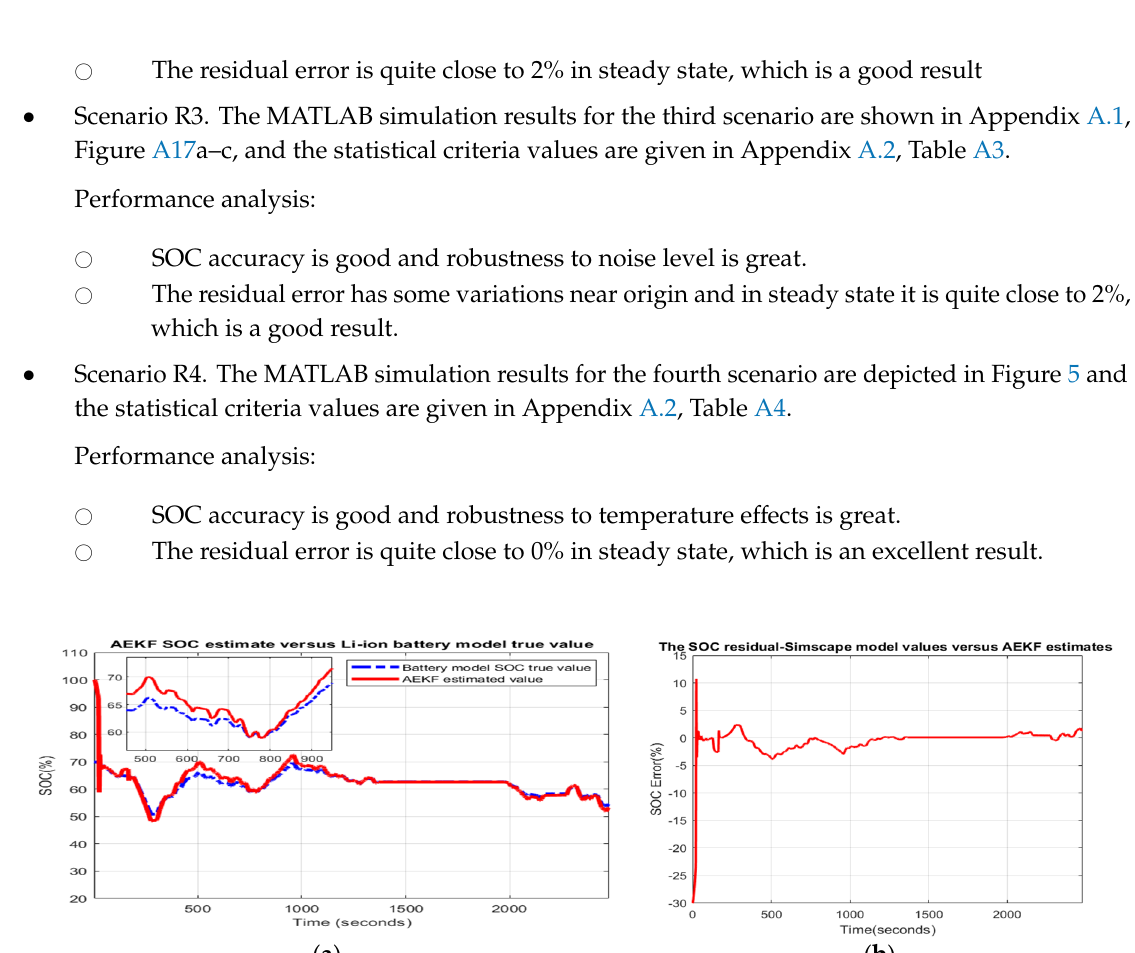
( b ) Figure 3. Robustness to simultaneous changes, SOCini = 0.2, and output temperature profile changes; ( a ) AEKF SOC value versus battery model true value; ( b ) SOC residual.